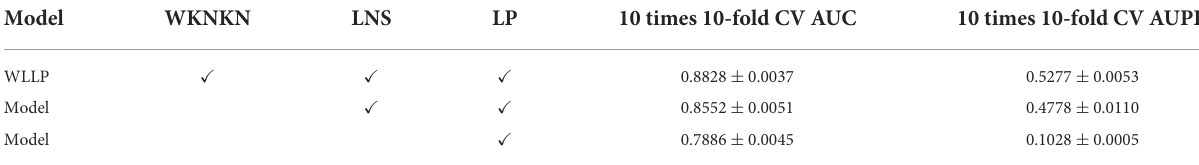
TABLE 2 Results of ablation experiments for the weighted reconstruction-based linear label propagation algorithm (WLLP)